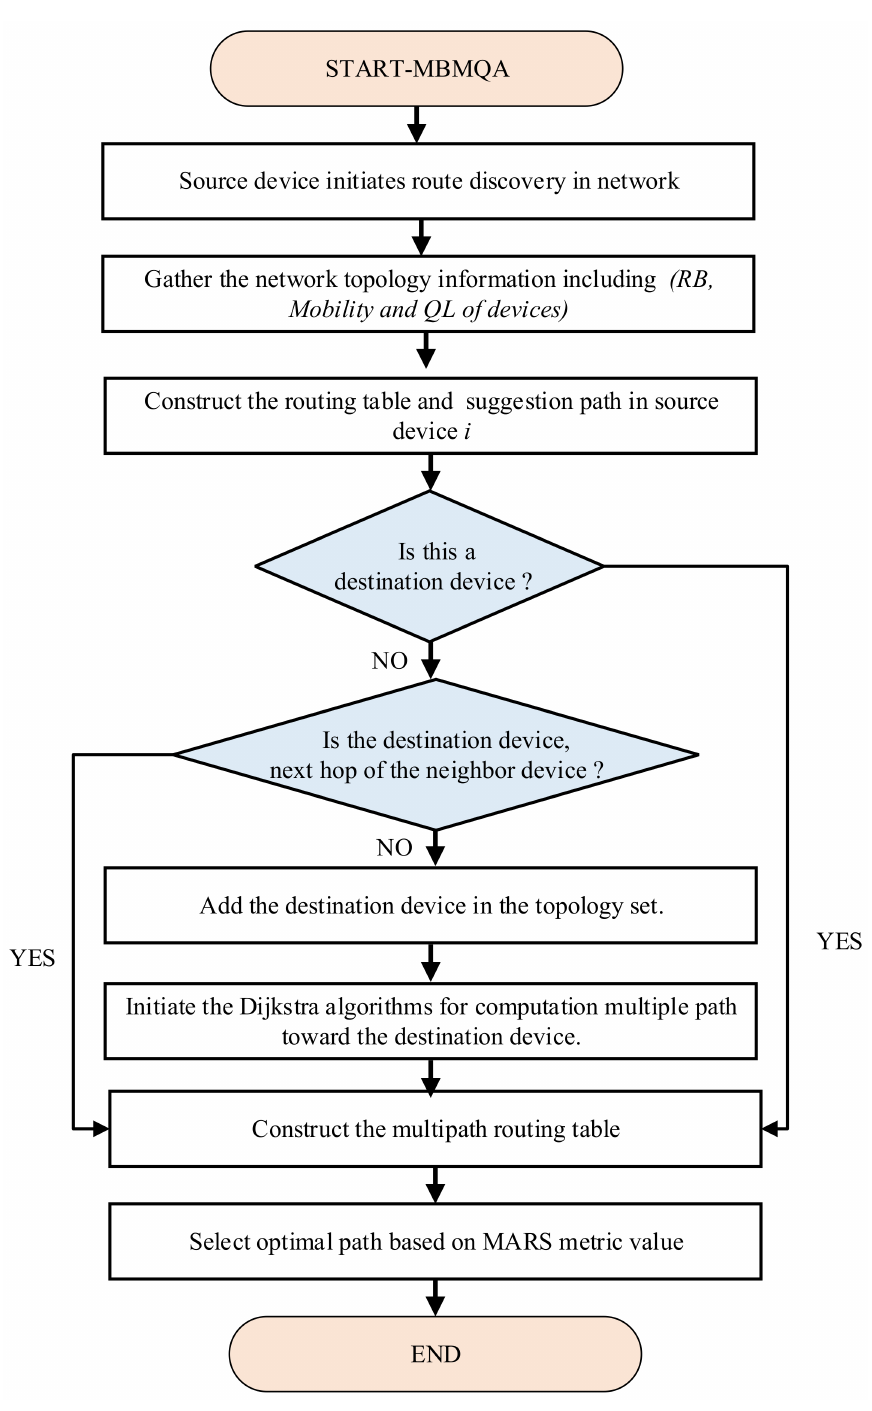
Figure 2. Flowchart of the computation route in MBMQA